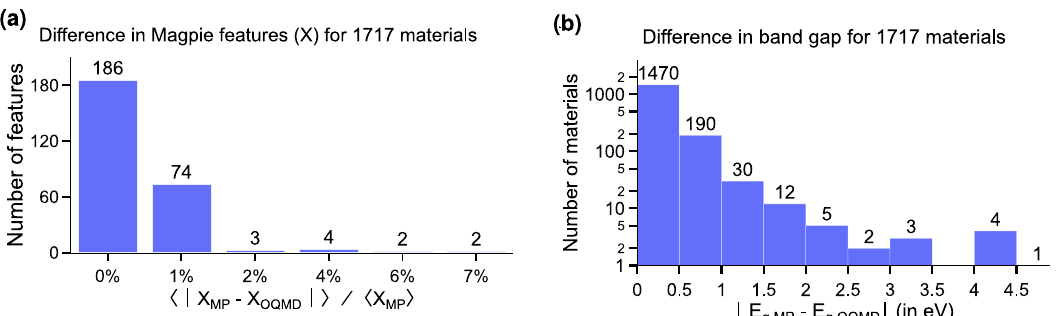
Fig. 2 Comparison of material representation vectors between the OQMD and MP structures. The difference in material representation vectors of the structures obtained from OQMD and MP for 1717 materials. a Mean absolute difference in the Magpie-generated representational feature vectors on structures obtained from the MP and OQMD for 1717 materials in the training-data. Crystal structures of all 1717 materials were fi rst obtained from MP as a part of generating training-data, and further cross-referenced to fi nd their equivalent structures in OQMD based on their ICSD Collection Codes. ICSD Collection Codes were not available for the rest of the 143 materials in the MP training-data. b Difference in band gap values of 1717 materials from training-data that have a corresponding structure entry in MP and OQMD, which are cross-referenced based on their ICSD Collection